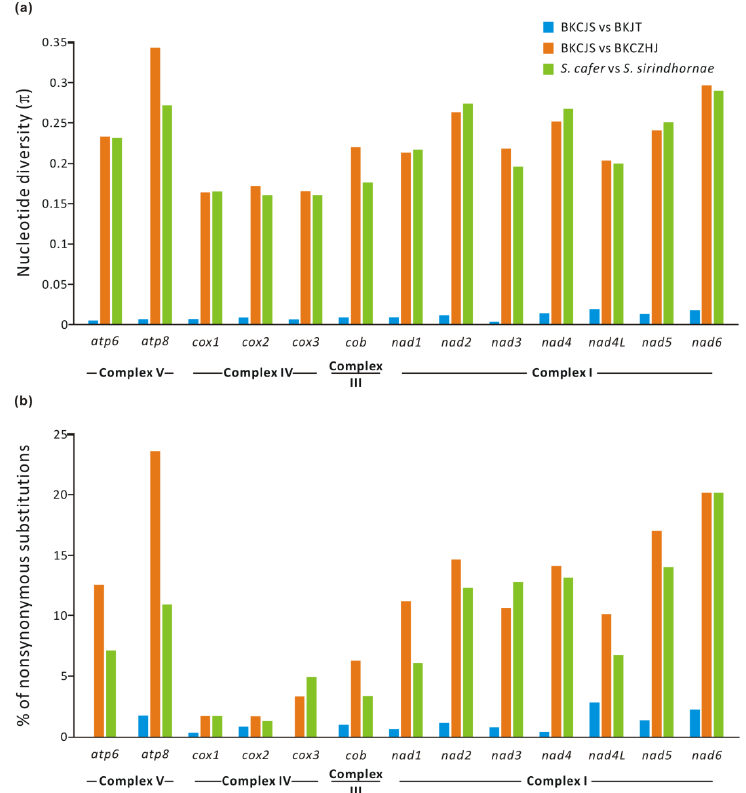
Figure 2. Sequence divergence across mitochondrial PCGs in B. kugenumaensis and interspecific variation in Streptocephalus . ( a ). Nucleotide diversity. The nucleotide diversity is plotted on the y -axis, and the PCGs are plotted on the x -axis. ( b ). Proportion in amino acid change per PCG. Abbreviations: BKCJS = B. kugenumaensis (Suqian, Jiangsu Province, China); BKJT = B. kugenumaensis (Naruto, Tokushima Prefecture, Japan); BKCZHJ = B. kugenumaensis (Jinhua, Zhejiang Province, China); S. = Streptocephalus